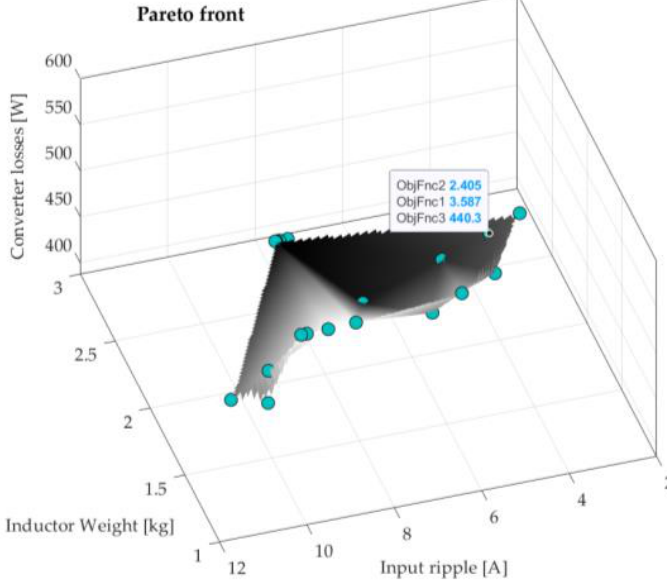
Figure 5. 3D Pareto-front (non-dominated optimal solutions) obtained by NSGA-II and the optimal solution determined by AR. Table 6. Optimal solution for battery port in MPC.